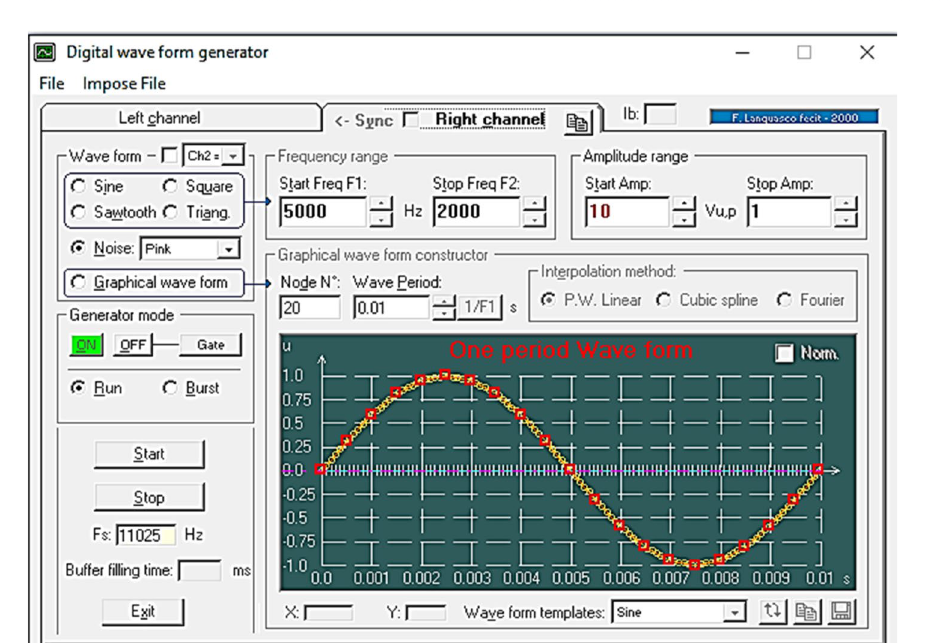
Figure 3. Schematic of the lab-written Visual Basic 6 ( VB 6 ) software to generate electrical current based